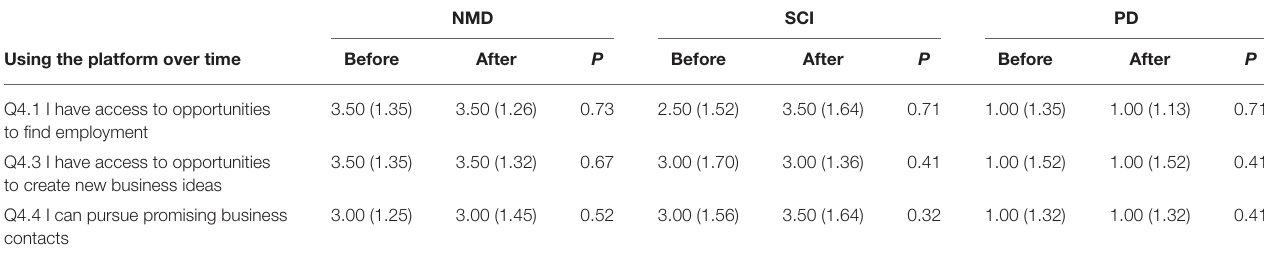
TABLE 9 | Descriptive statistics (median and standard deviation) for answers to the employment indicator questions and comparison using Wilcoxon Non-parametric statistical test. NMD SCI PD Using the platform over time Before After P Before After P Before